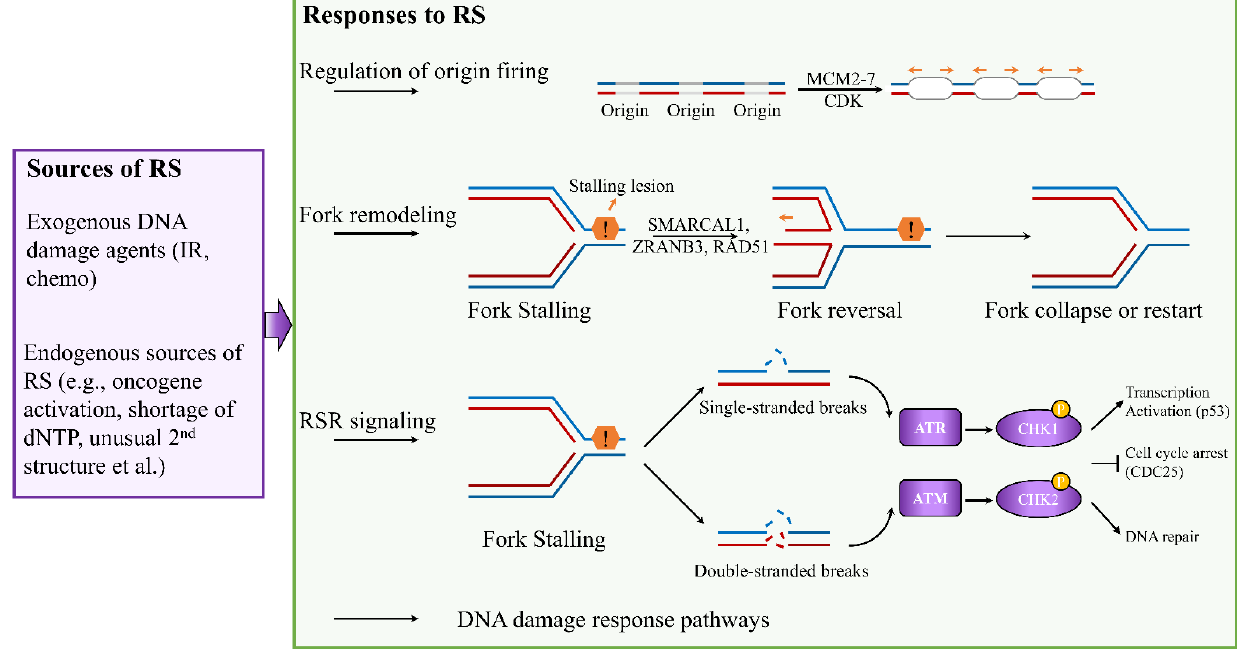
Figure 1. Cellular responses to DNA replication stress. Depending on the types of RS, cells activate numerous responses to ensure accurate completion of genome duplication, including regulation of origin firing, replication fork remodeling, activation of RSR signaling, and involvement of DNA damage response pathways.